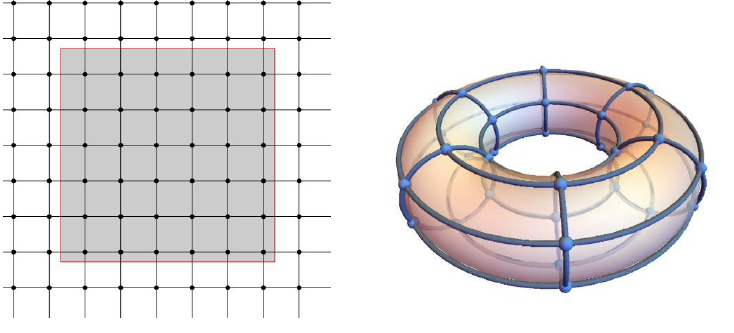
Figure 12. The drawing for ( m , n ) = ( 6,6 )